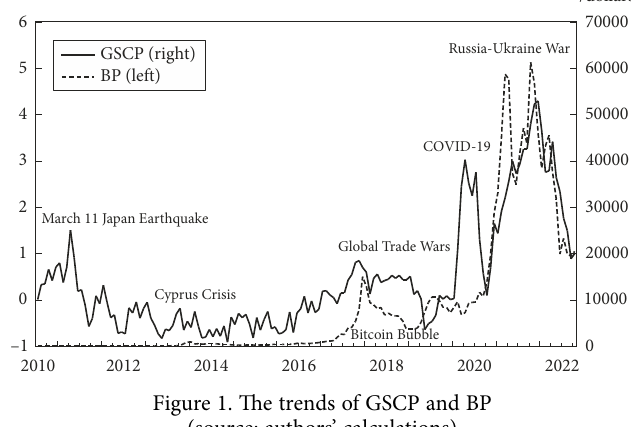
Figure 1. The trends of GSCP and BP (source: authors’